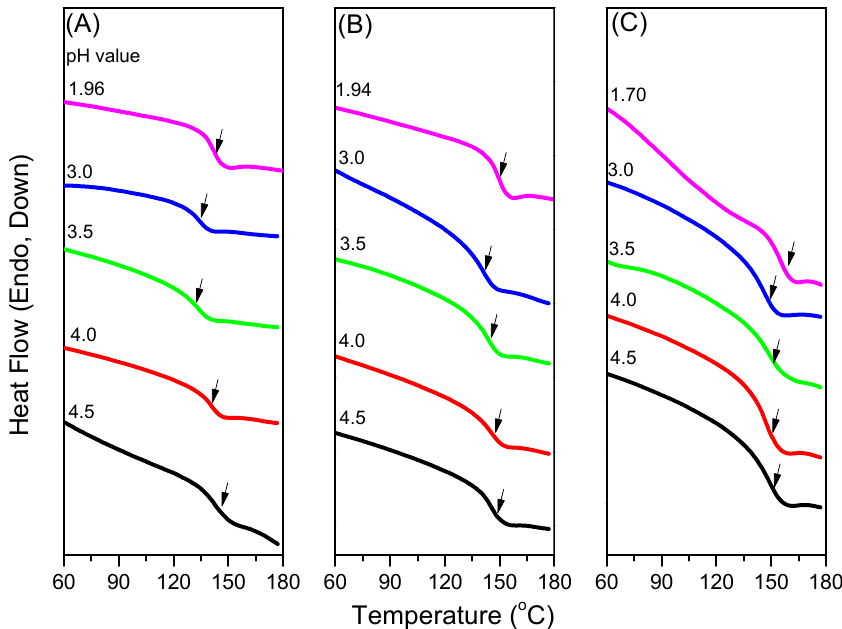
Figure 10. DSC thermograms of: ( A ) PNIPAAm97- co -PAA3; ( B ) PNIPAAm87- co -PAA13; and ( C ) PNIPAAm80- co -PAA20 films cast from aqueous solutions at various values of pH.